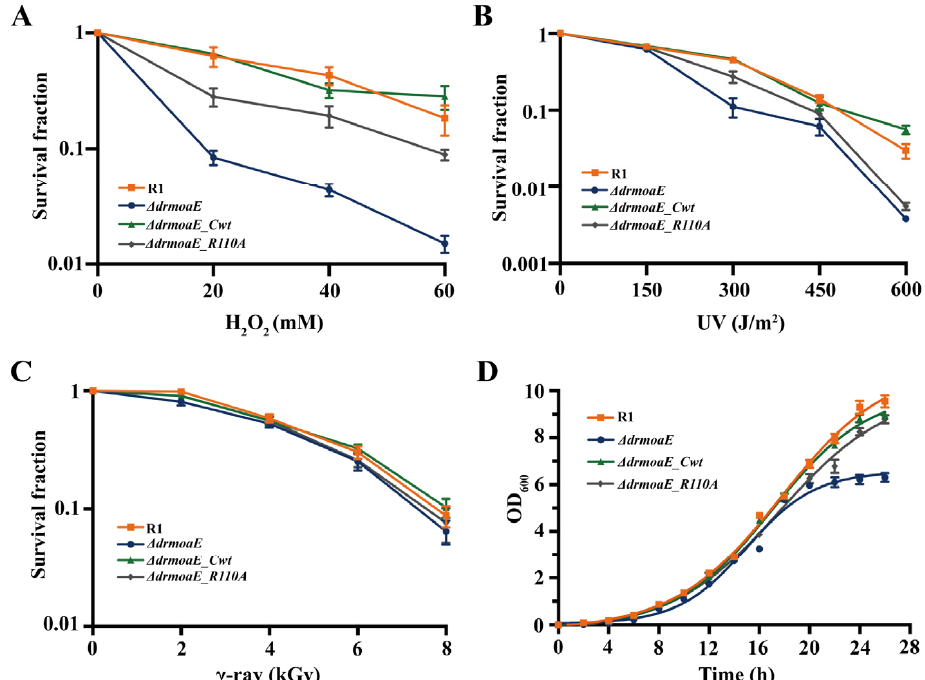
Figure 3. Phenotype and growth analysis of drmoaE . (A) Survival curves of the wild-type strain (R1), the mutant strain ( Δ drmoaE ), and the complementary strain ( Δ drmoaE_Cwt and Δ drmoaE_R110A ) under H 2 O 2 (0–60 mM), respectively. (B) Survival curves of the wild-type strain (R1), the mutant strain ( Δ drmoaE ), and the complementary strain ( Δ drmoaE_Cwt and Δ drmoaE_R110A ) under UV (0–600 J/m 2 ), respectively. (C) Survival curves of the wild-type strain (R1), the mutant strain ( Δ drmoaE ), and the complementary strain ( Δ drmoaE_Cwt and Δ drmoaE_R110A ) under γ -ray (0–8 kGy), respectively. (D) Growth curve of the wild-type strain (R1), mutant strain ( Δ drmoaE ), and complementary strain ( Δ drmoaE_Cwt and Δ drmoaE_R110A ). Each value represents the mean of three assays (mean ± SD).